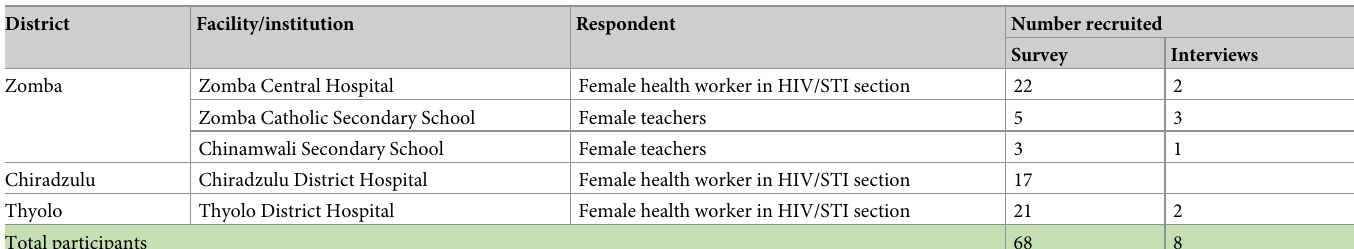
Table 1. Facilities and institutions where respondents were selected.